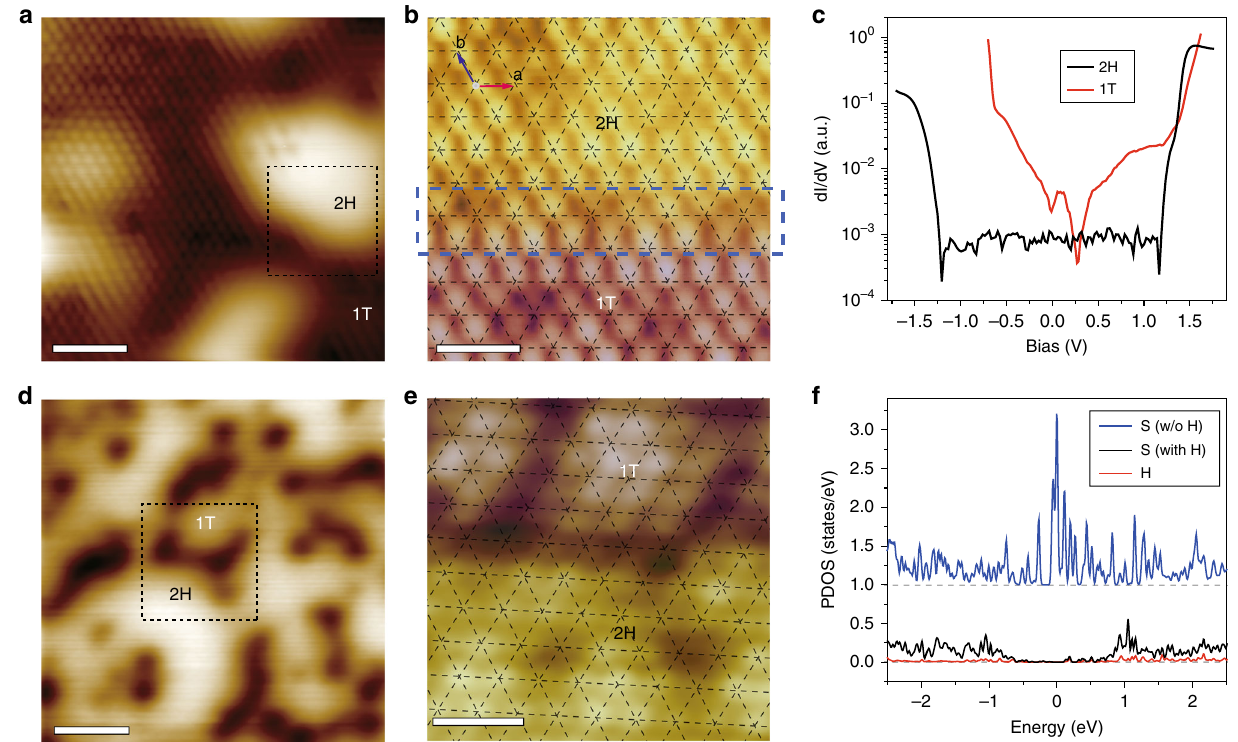
Fig. 2 Hydrogen adsorption at 2H – 1T-phase boundaries. a STM topography of as-treated MoS 2 showing mixed 2 H (bright) and 1 T (dark) domains. b Zoom-in image of a domain boundary as denoted by a dashed square in a , where 2H and 1T phases are rendered with yellow and purple colors, respectively. The lattice grid of 2H phase is superimposed on the image to highlight the lateral sliding of S atoms in 1T phase. The black arrows indicate the sliding direction [120]. The two in-plane primitive vectors are shown in the upper left of b . c dI/dV spectra taken on the 2H and 1T phases, suggesting the semiconducting 2H phase with a 2.5-eV bandgap and metallic 1T phase. d STM image of the MoS 2 after hydrogenation, showing prominent depression features. The sample bias was chosen such that the apparent heights of 2 H and 1 T phases become similar, to highlight the depression features. e Zoom-in image of the depression features as denoted by a dashed square in d , indicating that the depression features are located exactly at the boundary of 2H and 1T phases. Set points of the STM images: a : 1.5 V, 50pA; b : 1 V, 10 pA; d : 2 V, 10 pA; e : 0.5 V, 50pA. Set point of dI/dV spectra:1.5 V, 50 pA c . f Projected density of states (PDOS) of S and H atoms at the phase boundary before and after hydrogenation. Blue curve: PDOS of S atoms before hydrogenation, black curve: PDOS of S atoms with H bonded, red curve: PDOS of absorbed H atoms. Scale bar: 2 nm a , 0.7 nm b , 1.5 nm d , 0.7 nm